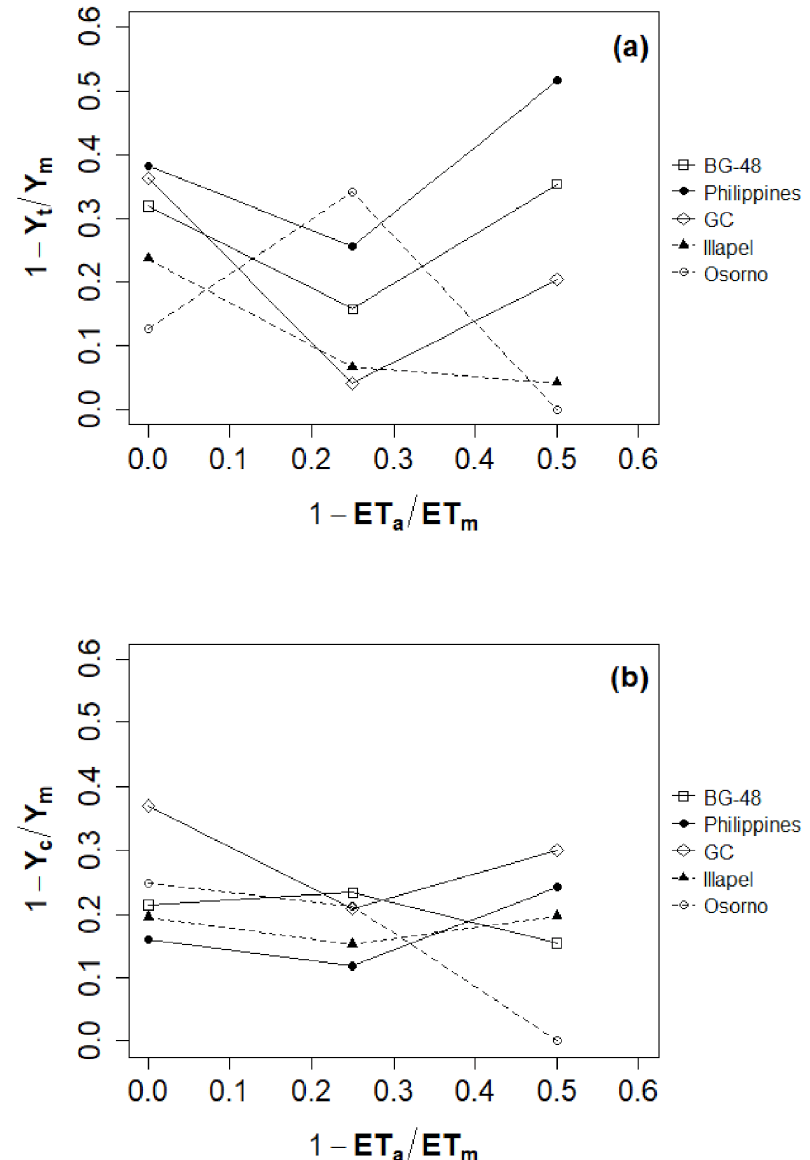
Figure 2. Relationship between relative evapotranspiration deficit (1 − ET a /ET m ) and relative total yield decrease (1 − Y a /Y m ) ( a ) and relative marketable yield decrease (1 − Y c /Y m ) ( b ) of watermelon cv. Santa Amelia F1 grafted onto five L. siceraria rootstocks. Table 3. Type III analysis of rootstocks (R), irrigation levels (I), and their interaction (R*I) on the total root length (TRL), root surface area (SA), root volume (RV), and the number of tips (NT) of five L. siceraria rootstocks grafted onto watermelon cv. Santa Amelia F1 and grown under field conditions. SV